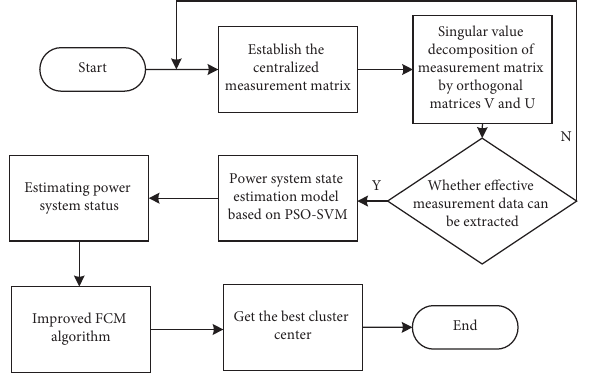
Figure 1: Power system state estimation anomaly detection fow chart.